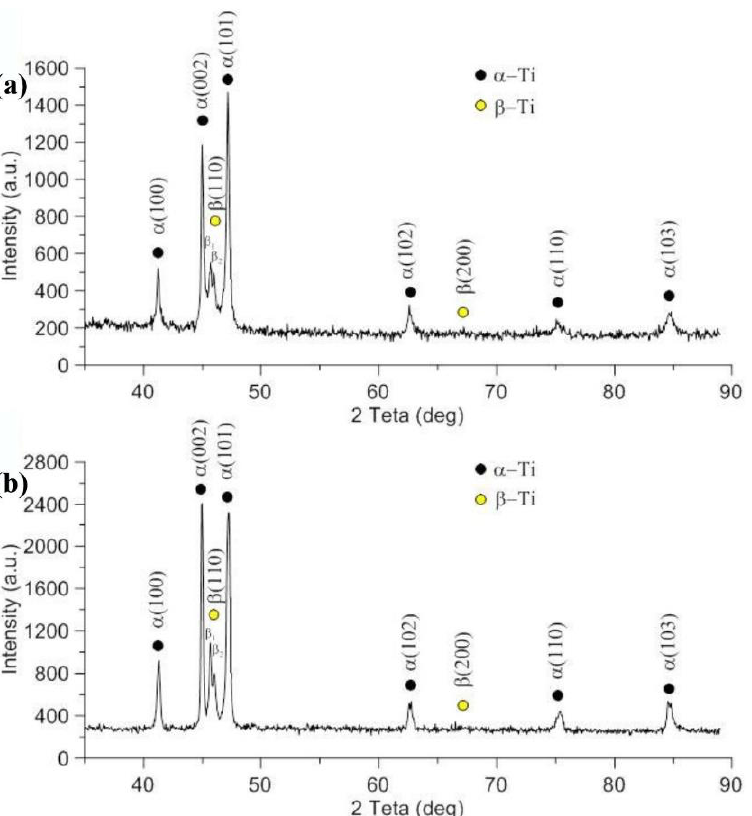
Figure 18. XRD spectra of the Ti-4Al-3Mo-1V alloy joint ( a ) and the Ti-4Al-3Mo-1V — Ti-6Al-4V alloy joint ( b ).